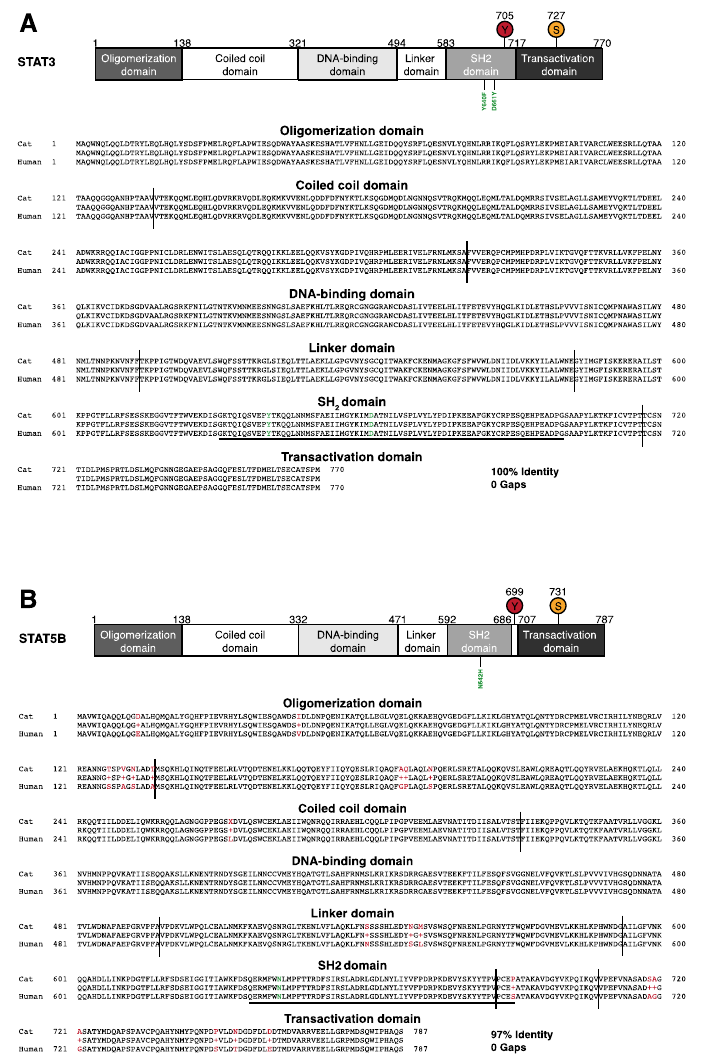
Figure 1. High conservation between feline and human STAT3 and STAT5B. ( A ) Schematic representation of protein domains in STAT3. Top panel: The position of amino acids at the beginning and the end of the respective domains are indicated above the scheme, including tyrosine and serine phosphorylation sites. Two important sites for mutation, Y640 and D661 (marked in green), are shown underneath. Lower panel: Alignment of cat and human STAT3, with protein domains indicated. The amino acid sequence corresponding to the exon sequenced in later analyses (Figure 4) is underlined, Y640 and D661 are marked in green. ( B ) Top panel: Schematic representation of STAT5B as in ( A ). Lower panel: Alignment of cat and human STAT5B, with protein domains indicated. Human and cat STAT5B show 97% identity and no gaps, mismatched amino acids are given in red, N642 is marked in green. The amino acid sequence corresponding to the exon sequenced in later analyses (Figure 4) is underlined.